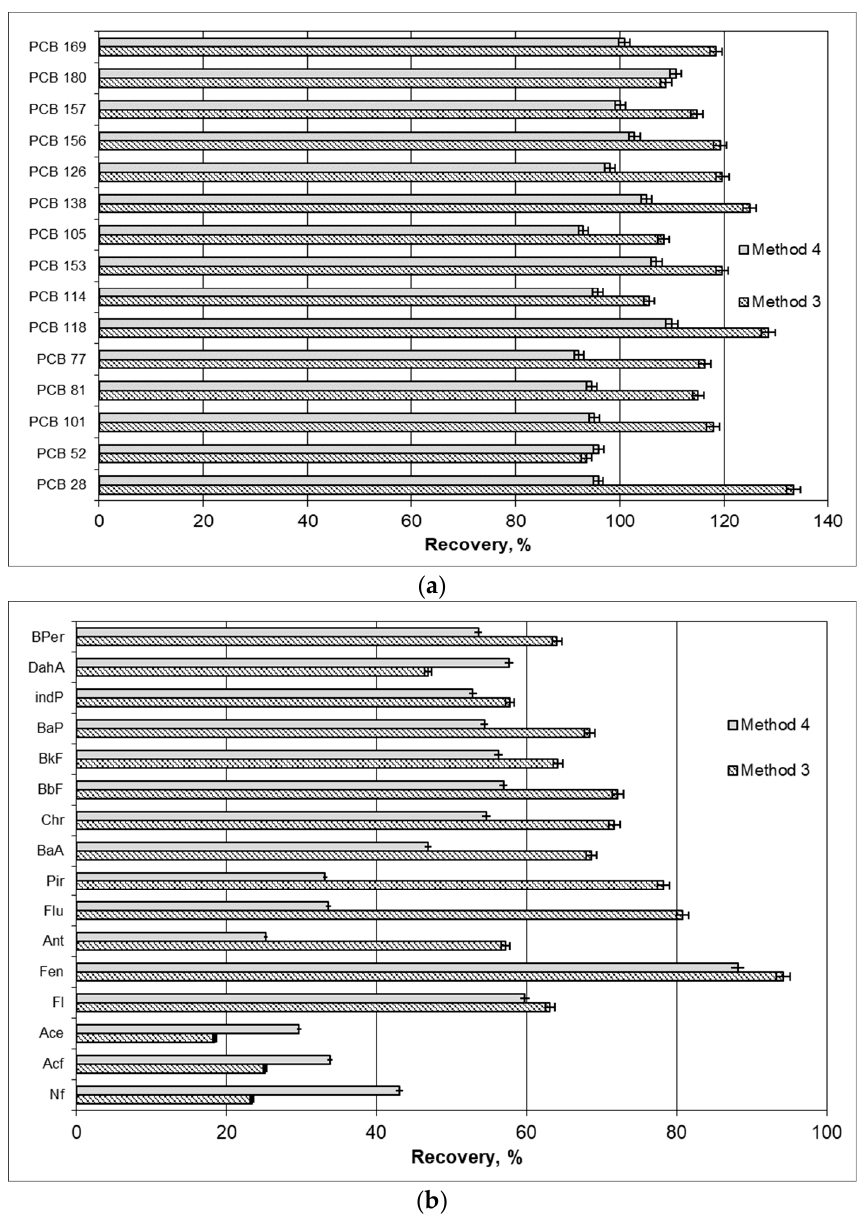
Figure 3. Recovery of PCBs congeners ( a ) and PAHs ( b ) (method 3—according to Vives and Grimalt [32]; method 4—according to Jaouen-Madoulet et al. [33]). As with PCBs, the values of all 16 PAHs determined with methods 2, 3, and 4 differed depending on the method. Differences among results obtained with method 2 and methods 3 and 4 revealed that, especially with heavy PAHs, their contents were overestimated (Figure 4, Table 4). The contents of BaP determined with methods 3 and 4 were three and fi ve times higher than that determined with method 2.